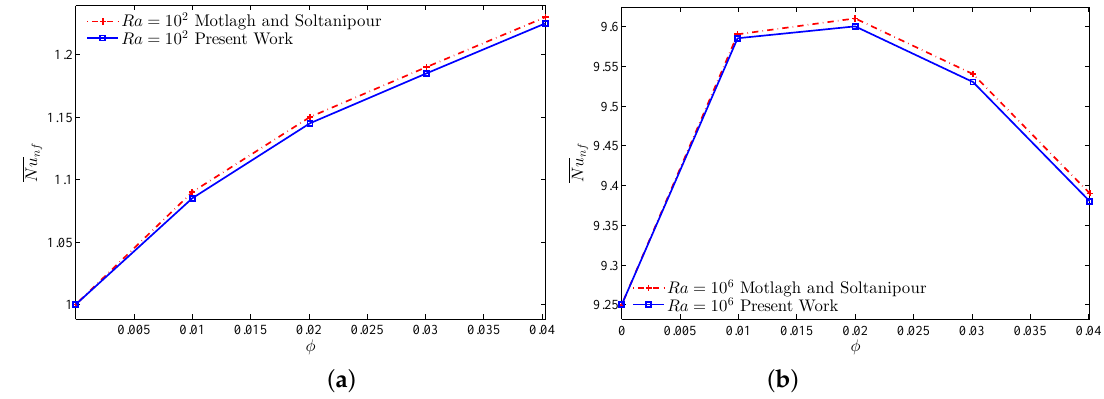
Figure 5. Comparison of average Nusselt number with Motlagh and Soltanipour [19] for ( a ) Ra = 10 2 and ( b ) Ra = 10 6 at D =